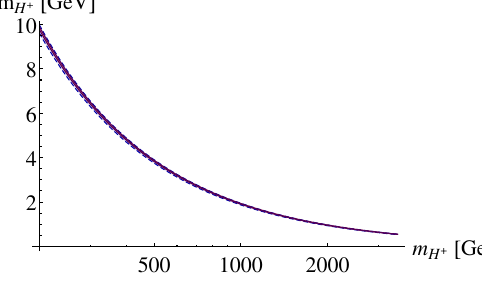
Stable solutions are marked in blue with dashed lines, unstable solu- tions in violet. The width of the bands is the variance in uncertainty generated by working at different values of tan( β )